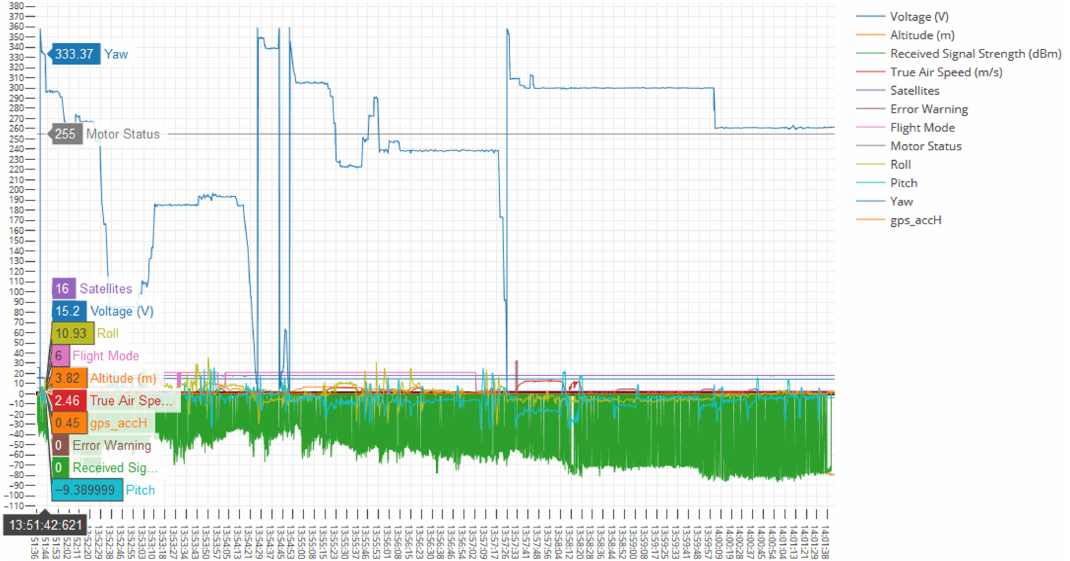
Figure 10. Drone black-box information.